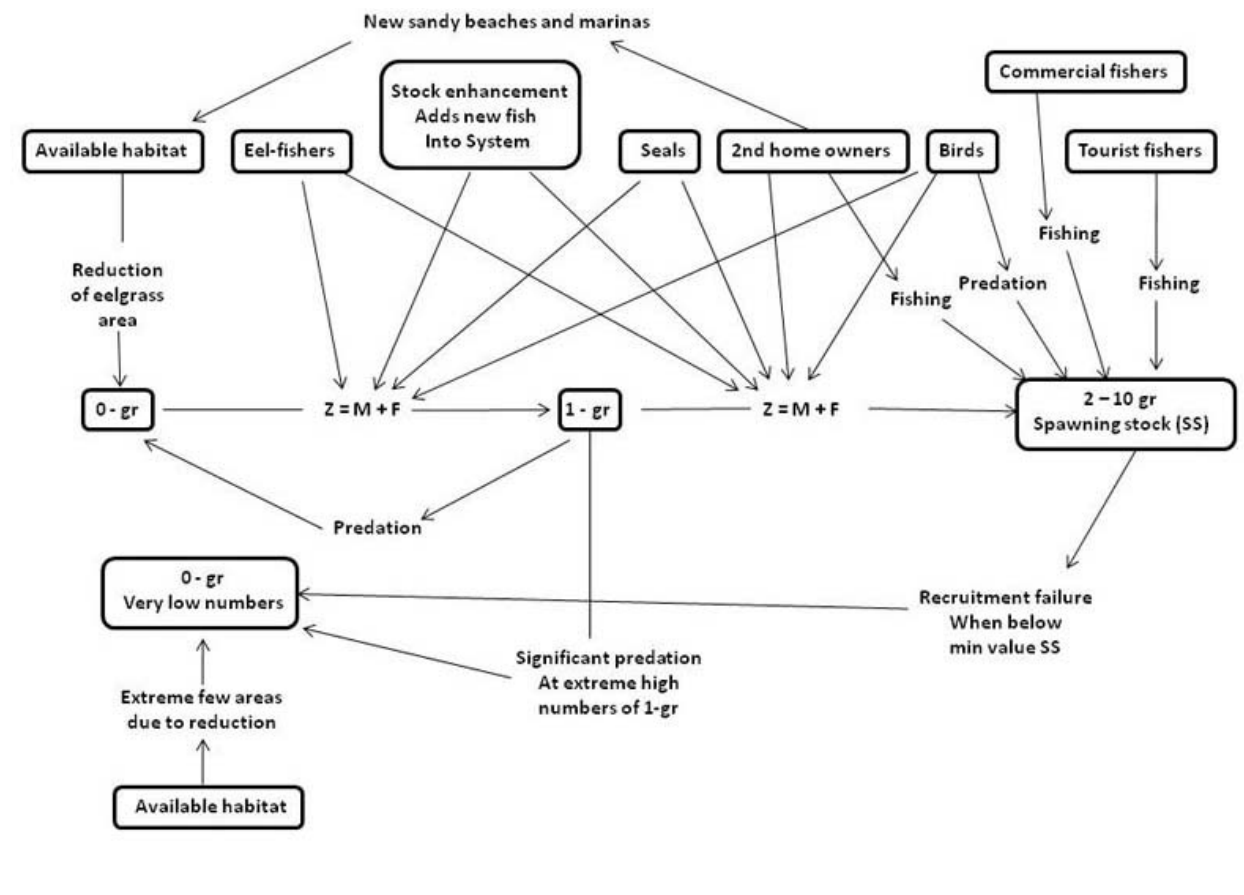
Fig. 1. Conceptual model of the cod life history, with the main factors affecting mortality. Z = total mortality, M = natural mortality, F = fishing